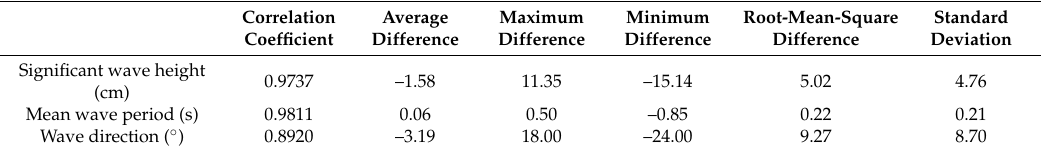
Figure 15. Comparison of significant wave heights between the SBF7-1A GPS wave buoy and the DWR-MKIII Waverider buoy after correction. Table 2. Comparison of results between the SBF7-1A GPS wave buoy and the DWR-MKIII Waverider buoy after